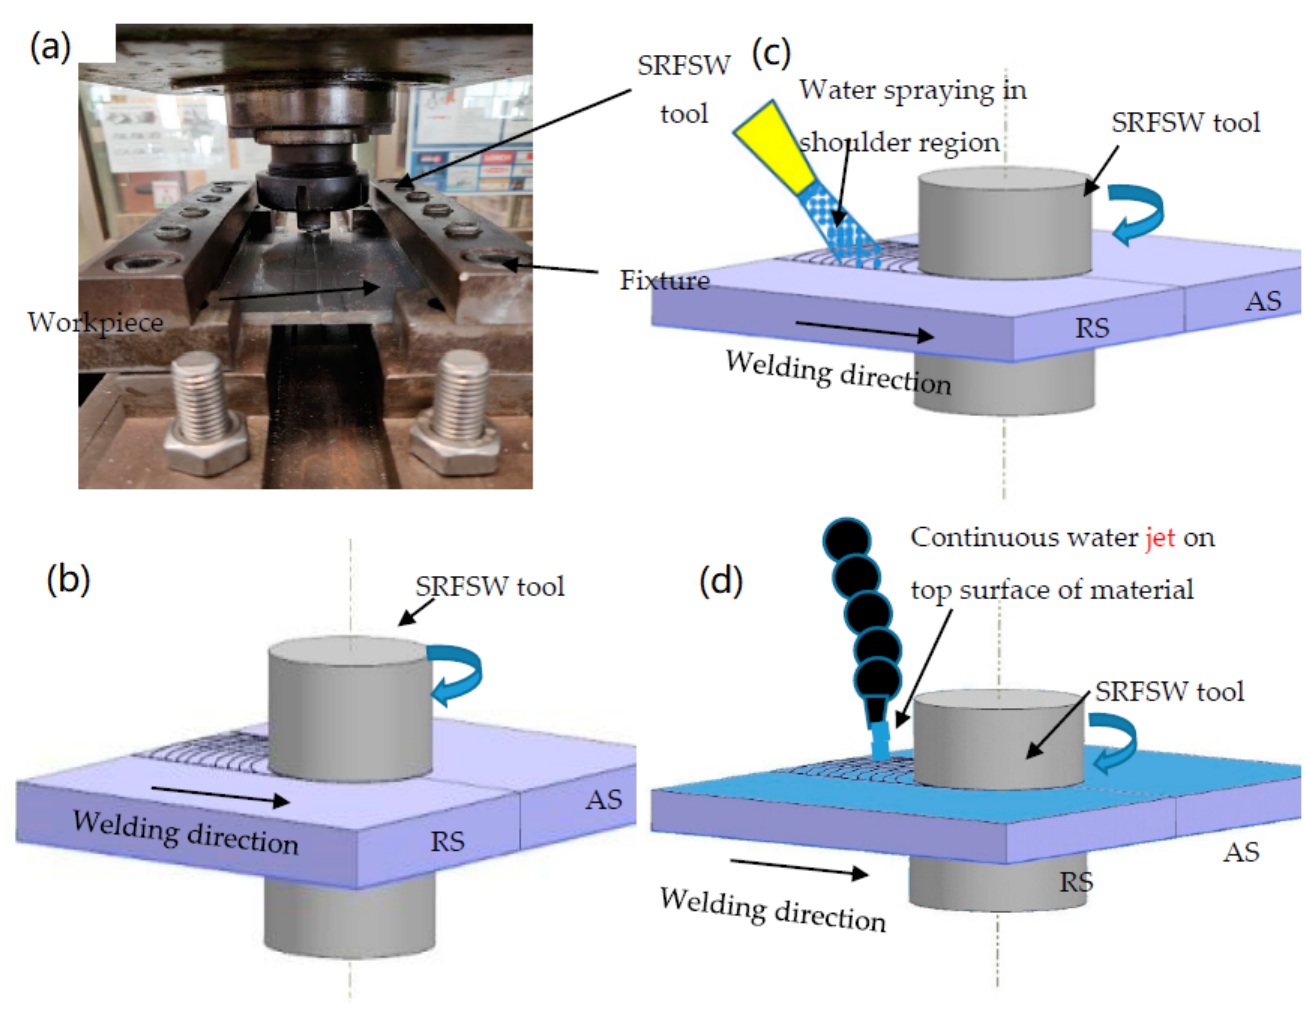
Figure 2. ( a ) Experimental set-up, ( b – d ) schematic of NAC, S-RM and S-IM, and C-RJ cooling assisted approach